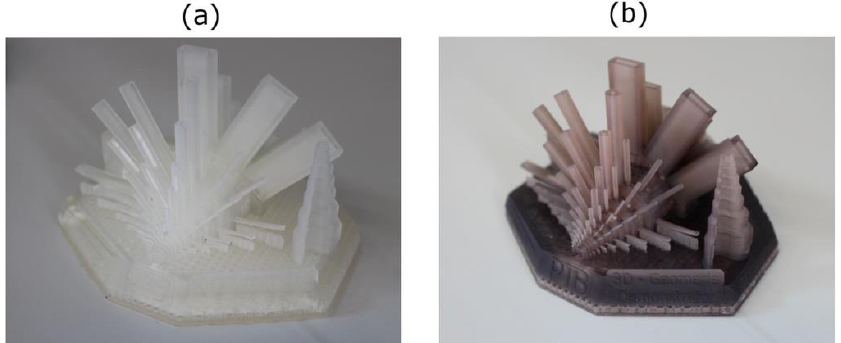
Figure 4. Three-dimensionally printed demonstrator using E-Shell without MNP ( a ) and with MNP ( b ) at a concentration c (of Fe) = 3.5 mg/mL. From [50], originally published under a CC-BY-NC-ND license